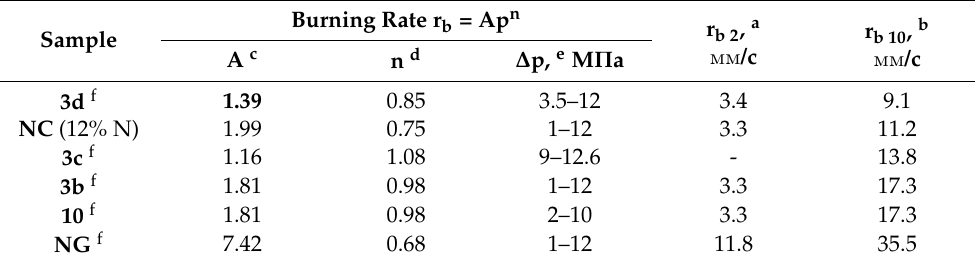
Table 6. Burning rate data of selected azides in comparison with NC and NG .